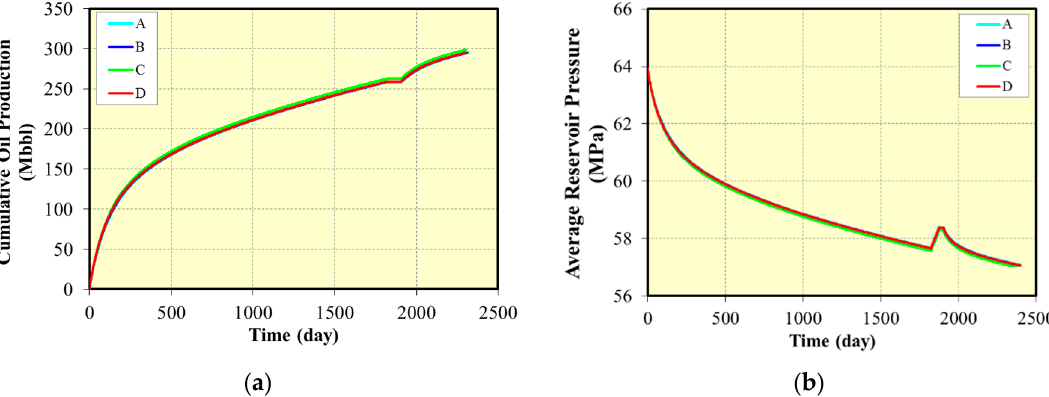
Figure 22. Effect of different types of SRV region with one huff-n-puff cycle on oil production and reservoir pressure: ( a ) Cumulative oil production for different types of SRV region; ( b ) Average reservoir pressure for different types of SRV region.